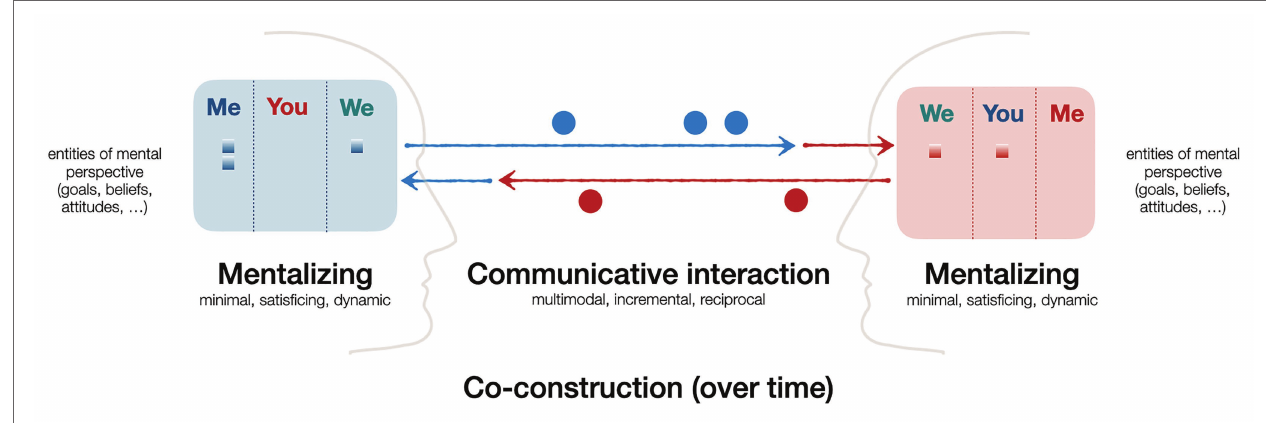
FIGURE 1 | Schematic overview of the role and interplay of mentalizing and incremental co-construction in cooperative communicative interaction (see text for